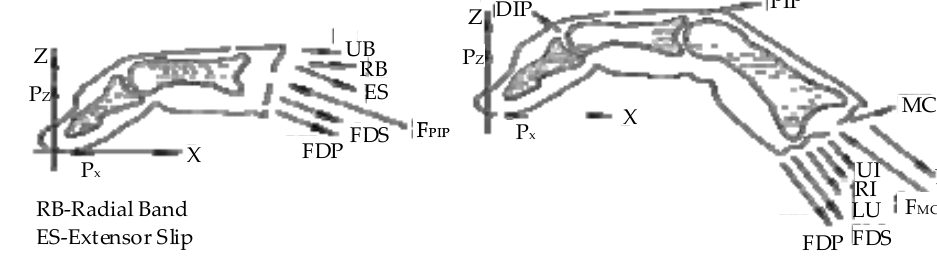
Figure 9. Finger biomechanical relationship.